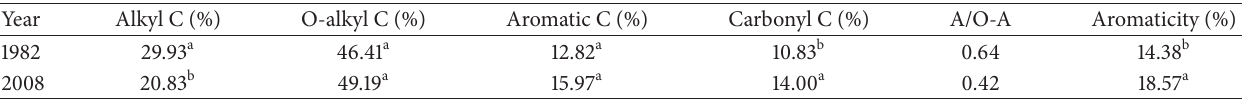
Table 4: Distributions of different chemical shift ranges in total signal intensity (%) for 13 C NMR in organic carbon of A horizon soil under a C. cathayensis forest stand sampled in 1982 and